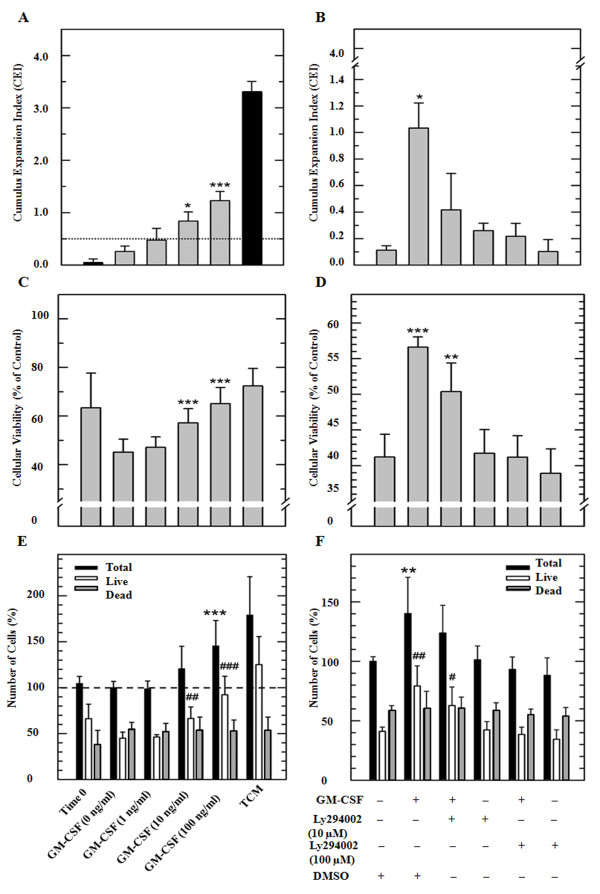
Effect of GM-CSF on cumulus cell in in vitro matured COC. (Left Graphs) COC were matured in SOF medium alone or supplemented with 1, 10 and 100 nM of GM-CSF. Parameters from cumulus cells derived from oocytes in the immature state and matured in TCM were used as positive control and not included in the statistical analysis. (Right Graphs) COC were matured in SOF medium supplemented with GM-CSF, LY294002 (10 or 100 μM) or DMSO. (A, B) Cumulus cell expansion was evaluated subjectively using the cumulus expansion index (CEI). (C, D) Cell viability was evaluated using Trypan Blue staining. (E, F) Cell number was determined using hemocytometer. (−−−) Corresponds with the lower limit for cumulus expansion (CEI ≥ 0.5). (*) Indicate significant differences between treatments of 0, 1 and 100 ng/ml of GM-CSF. *** P < 0.001, ** P < 0.01 and *P < 0.05. (#) Indicate significant differences compared with control ### P< 0.001, ## P< 0.01, # P < 0.05.